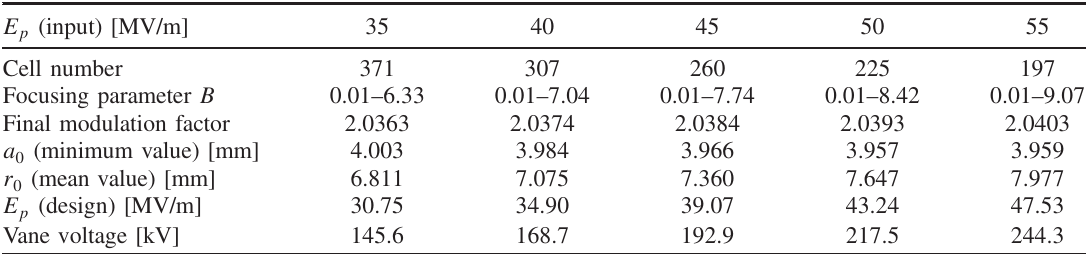
TABLE VIII. Cell parameters designed using RFQGen software with SC-RFQ for 5 MeV deuteron beam acceleration.